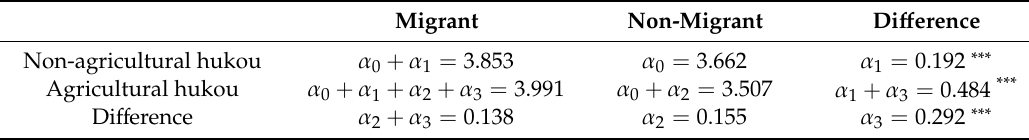
Table 4. The Di ff erence-in-Di ff erence construction and the numeric